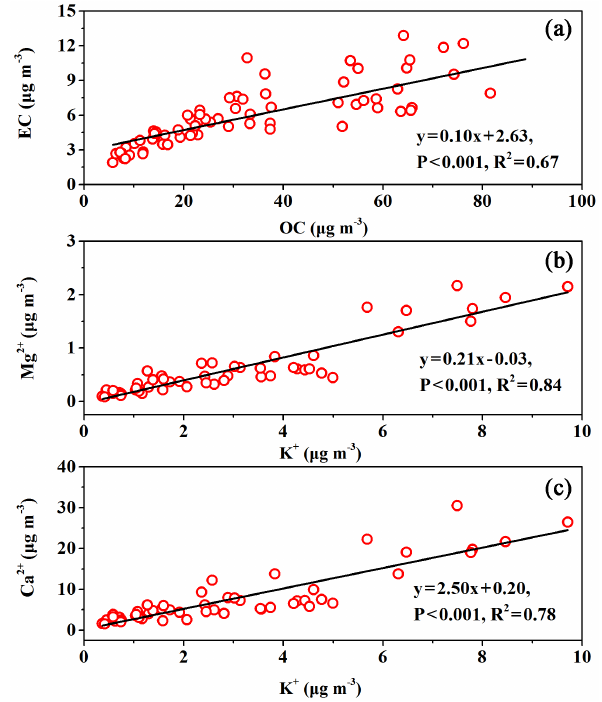
Figure 4. Correlations between (a) OC and EC, (b) K + and Mg 2 + , and (c) K + and Ca 2 + during the entire sampling period of a year (April 2013 to March